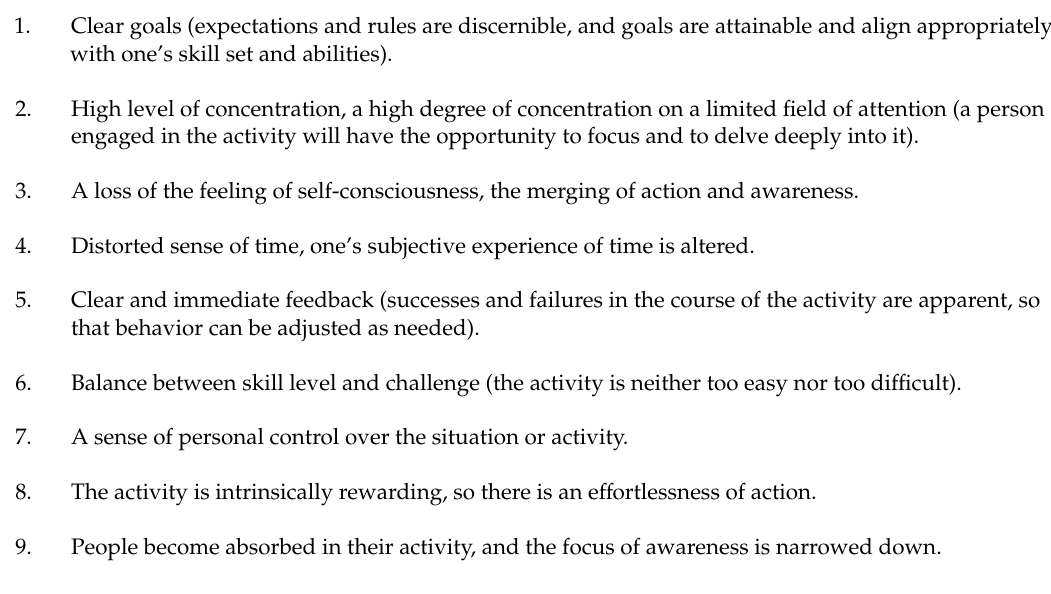
Table 1. Nine components associated with the flow state experience [9] (Csikszentmihalyi,